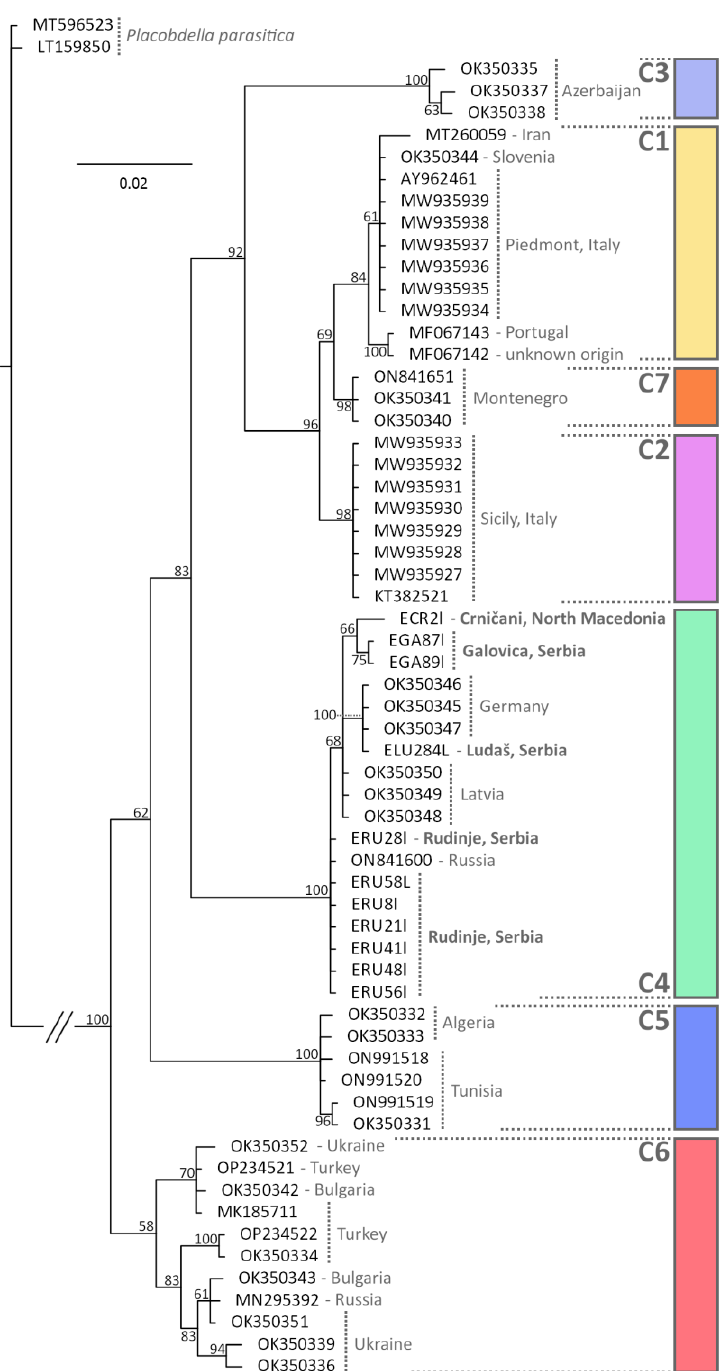
Figure 3. Estimate of phylogenetic relationships between lineages of Placobdella costata based on Bayesian inference of partial CO1 mitochondrial DNA sequences. Values next to nodes indicate % Bayesian Posterior Probabilities. Lineages (C1–C7) correspond to those previously identified by [23]. The tree was rooted using two examples of Placobdella parasitica .